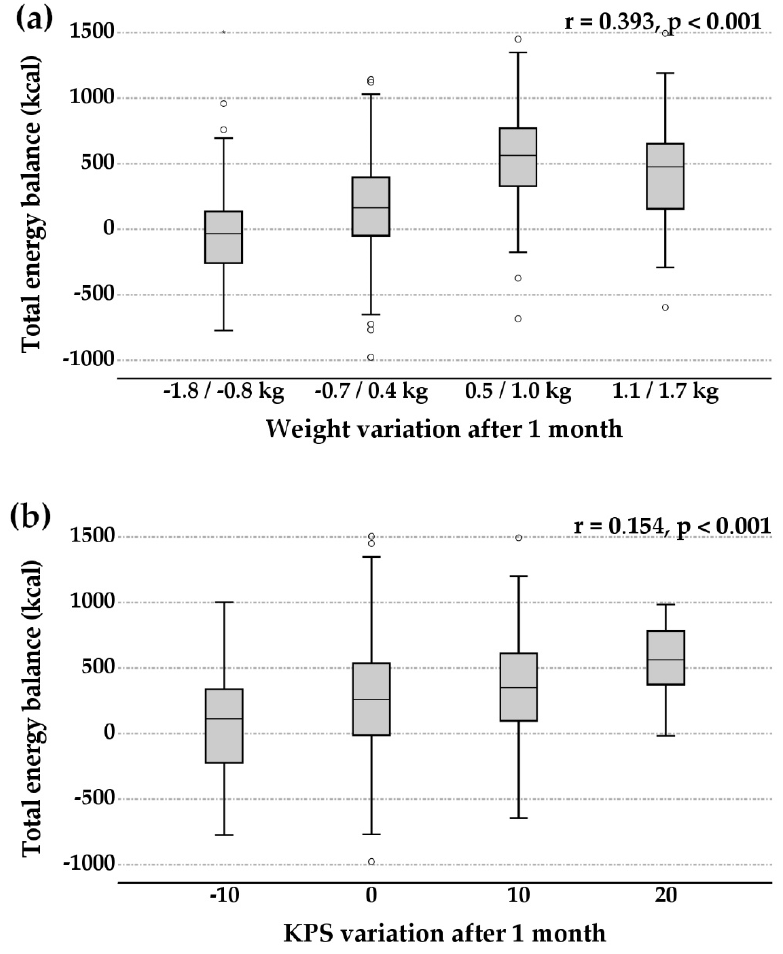
Figure 1. Weight and KPS variation after 1 month according to the total energy balance. Statistical analysis was performed by Spearman rank correlation.